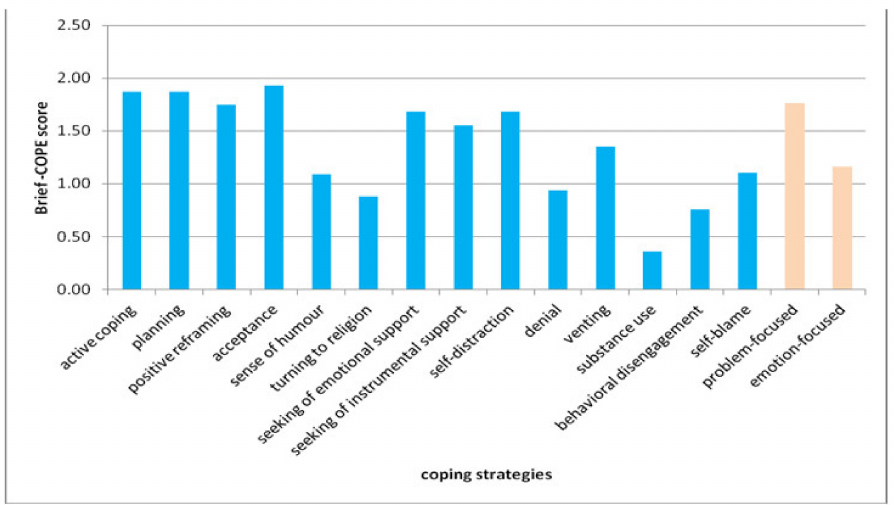
Figure 2. Use of coping strategies according to the Brief-COPE results in the study